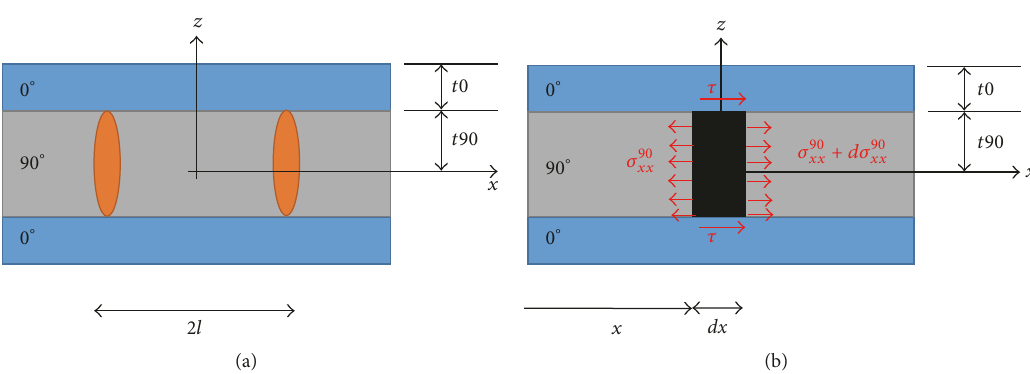
Figure 1: Unit cell for shear-load and variational methods. (a) Geometry. (b) Equilibrium. The crack is supposed to span all the laminate width, adapted from [12,